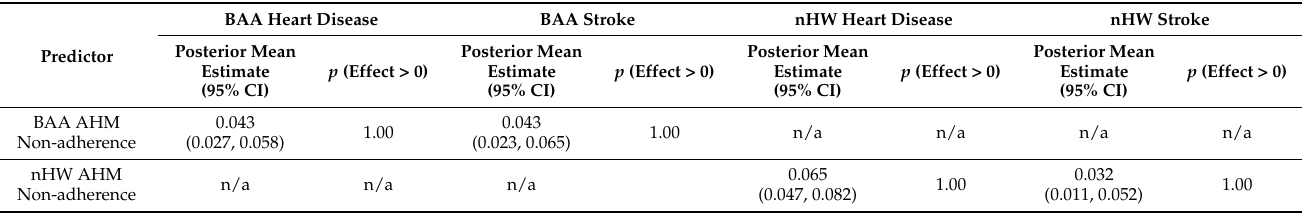
Table 3. Estimated posterior mean change of the average log rate of heart disease and stroke mortality for Black/African Americans and non-Hispanic Whites for a standard deviation increase of 1 in each covariate conditional on mean values of all other covariates among 875 counties in the